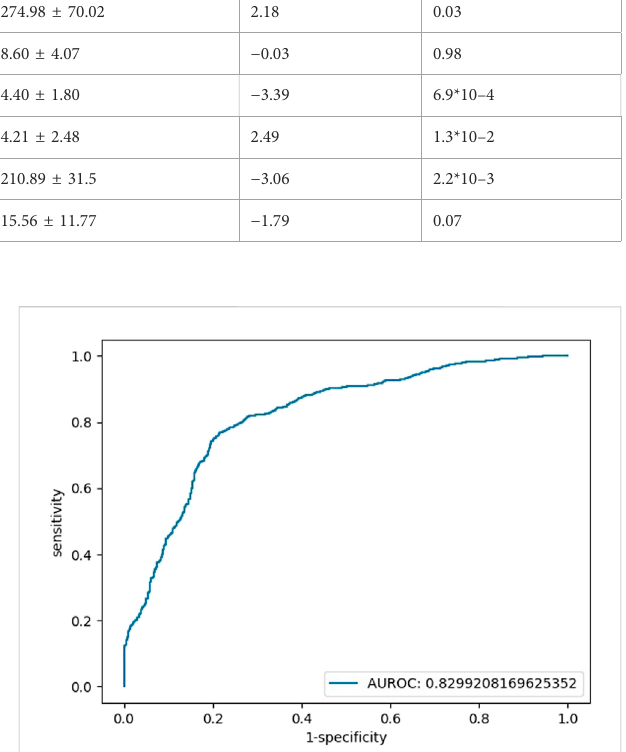
FIGURE 1 Testing set ROC curve of the early diagnosis of schizophrenia with the features of glucose, IBIL, and